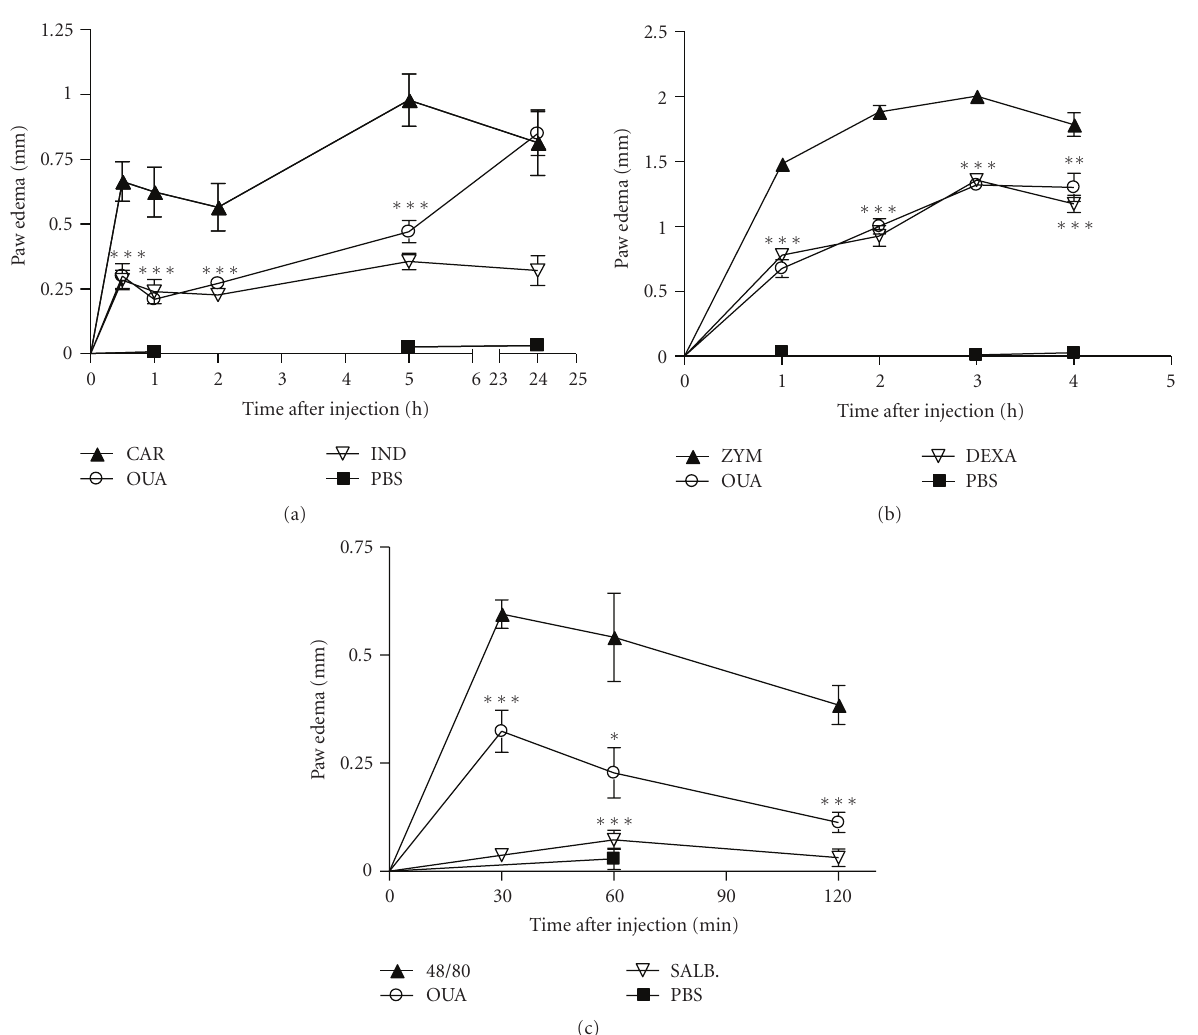
Figure 2: E ff ect of the pretreatment with Ouabain (OUA, 0.56mg/kg) administered intraperitoneally on paw edema triggered by carragenan (CAR), zymosan (ZYM), and compound 48/80 in mice. Mice received intraplantar injections of carrageenan (2.5%, (a)), zymosan(1%, (b)), or compound 48/80 (2 μ g/paw, (c)) in 20 μ L phosphate bu ff ered saline (PBS) in the right hindpaw and 20 μ L of PBS in the left hindpaw. Each point represents the mean of eight animals.Indomethacin (IND, 10mg/Kg), dexametasone (DEXA, 0.5mg/Kg), and salbutamol(SALB, 10mg/kg) were used as antiinflammatory controls and injected i.p. one hour before intraplantar challenge. Asterisks denote the significance levels compared with CAR, ZYM, or compound 48/80 group. Data were expressed as mean ± S.E.M. and analyzed by software Graphpad Prism using Student’s t -test followed by unpaired test ∗ P < . 05, ∗∗ P < . 01, and ∗∗∗ P < .